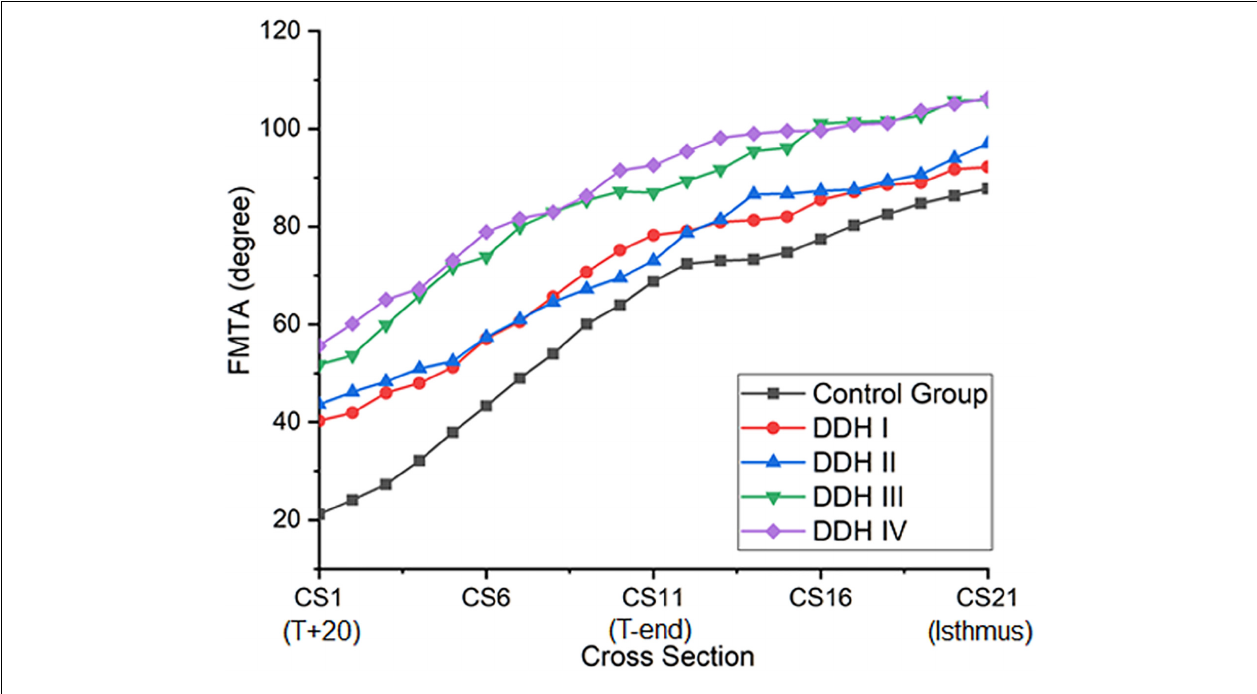
FIGURE 3 | The plot of femoral medullary torsion angle (FMTA) for all subject groups. TABLE 3 | The femoral medullary torsion angle (FMTA) in all subject groups.